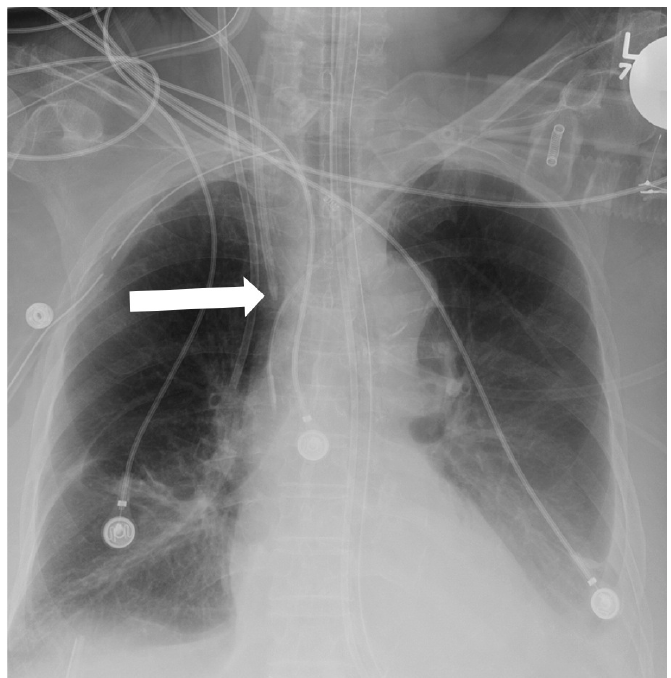
Figure 5. Portable chest radiograph showing mild cardiomegaly and bilateral basal lung opacities. A right internal jugular central venous catheter is shown with its tip apparently located at the superior vena cava. The emergency physician initially read the radiograph as showing the catheter as “adequately positioned.” Poor blood return was observed from the ports during placement. Chest burning pain was present during a normal saline infusion.